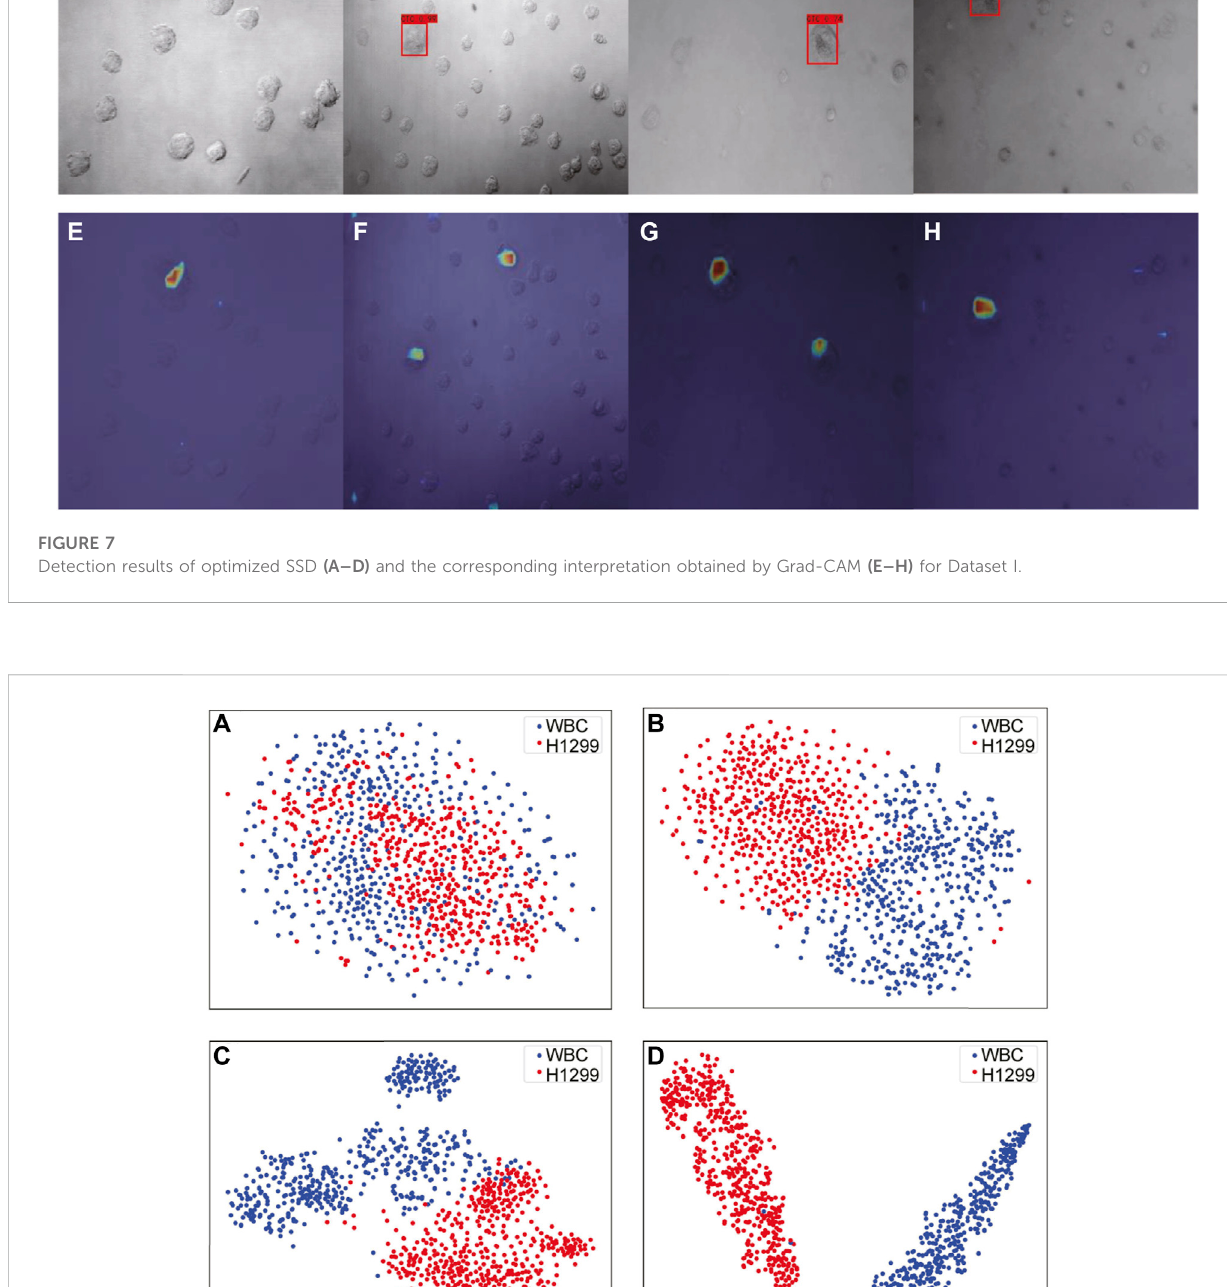
FIGURE 8 Dataset II visualization via T-SNE (A – D)